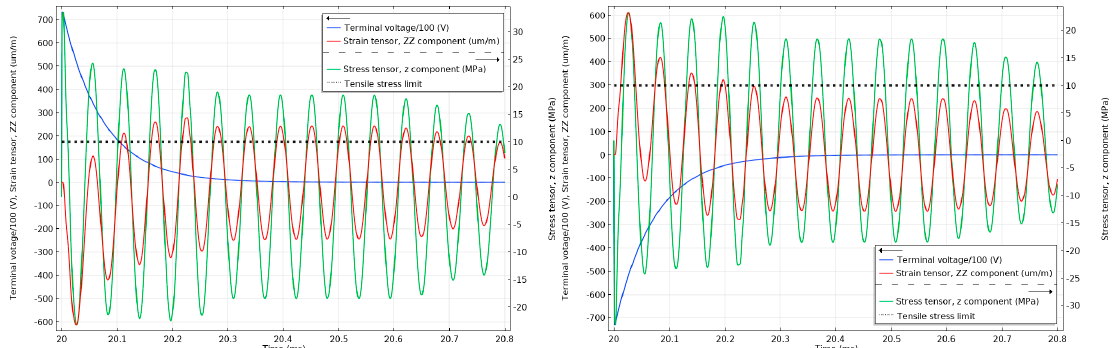
Figure 14. Stress and strain in the undamped stack when subjected to 1.2/50 µs 75 kV positive ( left ) and negative lightning impulses ( right ). The tensile stress limit of 10 MPa is marked by a black dotted line (the terminal voltage is the voltage applied to the top electrode of the stack.).